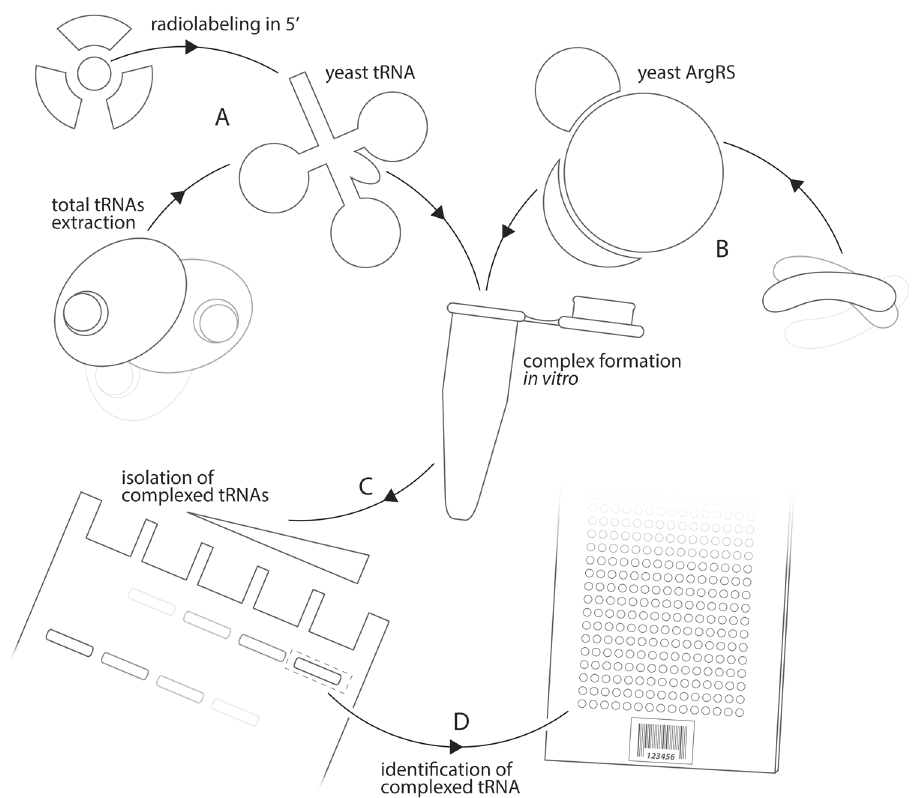
Fig 1. Schematic description of the method used for the identification of tRNA complexed by yArgRS. (A) Yeast total tRNAs were prepared by deacylation and gel purification of a yeast extract of total RNA and subsequently radiolabeled in 5 ’ with 32 P. (B) Yeast Arginyl-tRNA synthetase (yArgRS) was expressed as a recombinant protein in E . coli and purified by FPLC. (C) Fixed amounts of labeled tRNA were incubated 15 min on ice with varying amounts of purified enzyme ranging from 0.2 to 29 μ M. Free tRNAs were separated from complexed species on non-denaturing gel. (D) Complexed tRNAs corresponding to high molecular weight bands were eluted and hybridized on tRNA